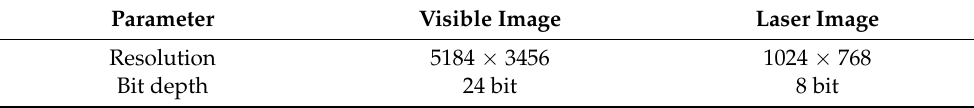
Table 1. Parameters of visible and laser images acquired.